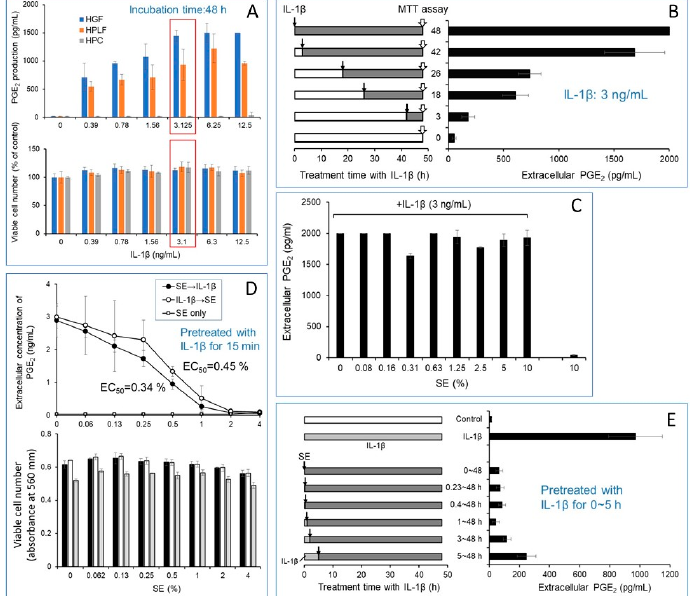
Figure 1. Kinetics of inhibition of IL-1 β -induced human gingival fibroblast PGE 2 production by SE. ( A ) Dose–response: IL- β stimulated the production of PGE 2 in HGF, HPLF, but not in HPC. ( B ) Time-course of PGE 2 production after IL-1 β (3 mg/mL) addition. ( C ) SE did not interfere with the PGE 2 measurement. ( D ) SE inhibited the IL-1 β -stimulated PGE 2 pro- duction more effectively when HGF cells were first treated by SE before IL-1 β addition. ( E ) Prolonged pretreatment with IL-1 β (3 mg/mL) reduced the inhibitory effect of SE to a greater